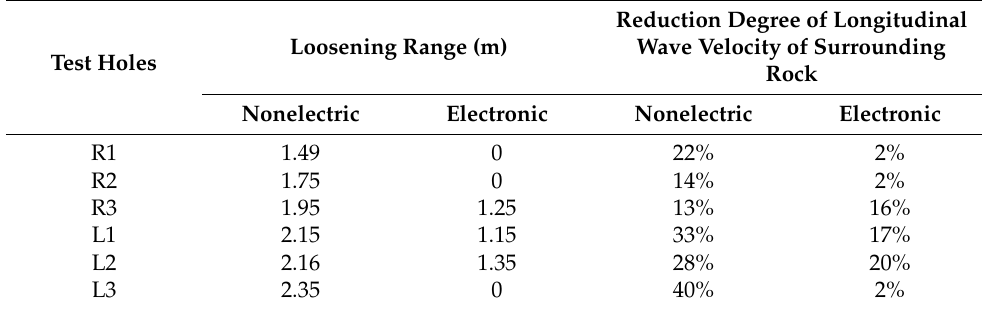
Figure 11. Schematic diagram of a loose circle during tunneling by nonelectric and electronic detonator blasting. Table 3. Property parameters of the tunnel nonelectric and electronic detonator blasting loose circle.